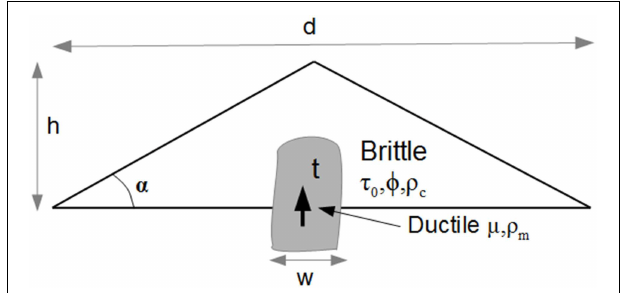
FIGURE 1 | Idealized example of ductile magma intruding a brittle cone. τ 0 , φ , ρ c are the cohesion, the angle of internal friction and the density of the brittle cone, respectively. µ and ρ m are the viscosity and the density of the magma, respectively. t is the time span for